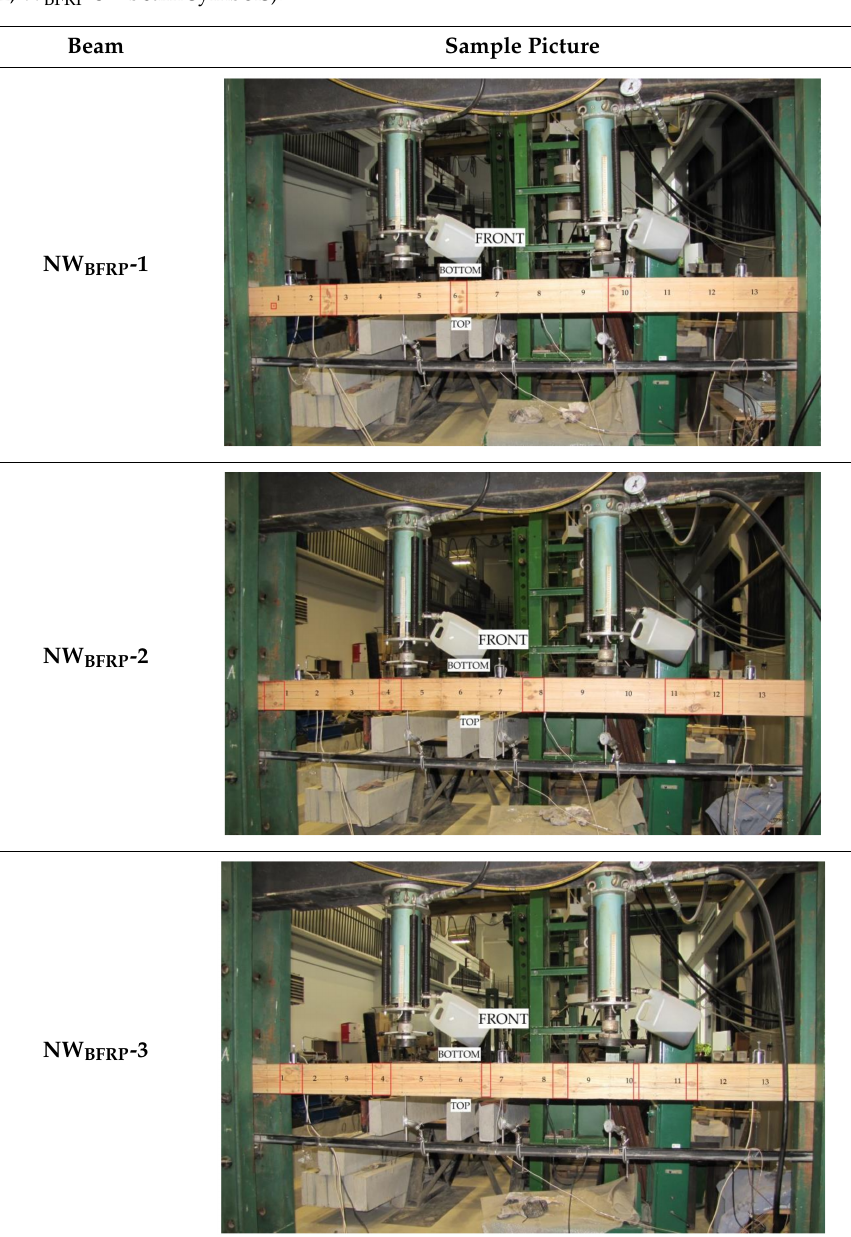
Table 1. Drawings with defects of sample wooden beams (NW BFRP -1, NW BFRP -2, NW BFRP -3, W BFRP -1, W BFRP -2, W BFRP -3—beam